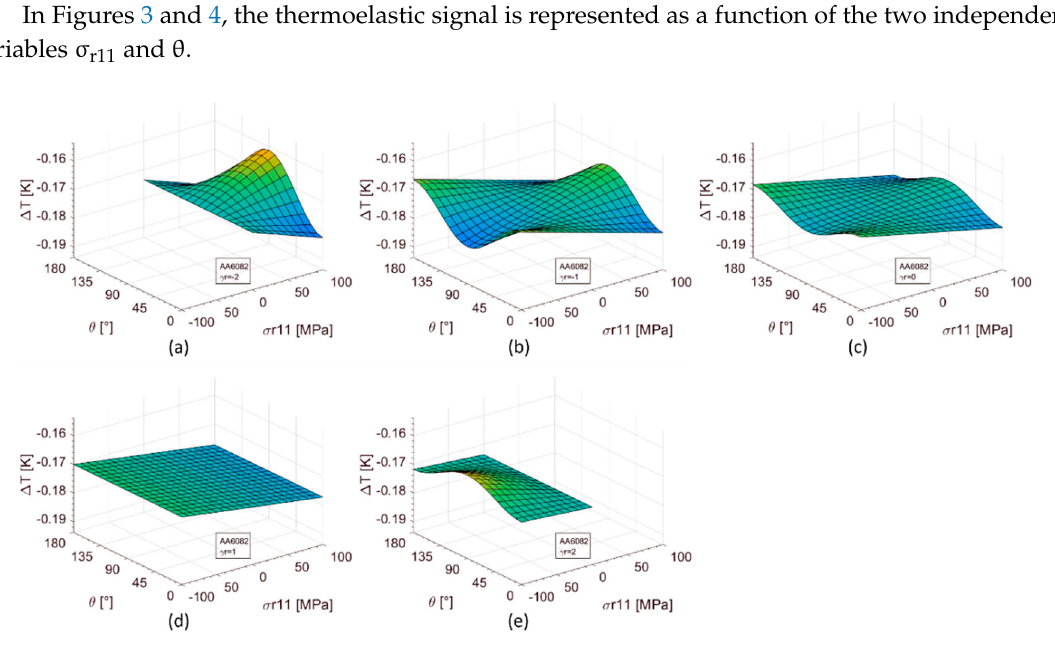
Figure 3. Thermoelastic signal as a function of the two independent variables σ r11 and θ for the alloy: ( a ) γ r = − 2 ( b ) γ r = − 1 ( c ) γ r = 0 ( d ) γ r = − 1 ( e ) γ r = −